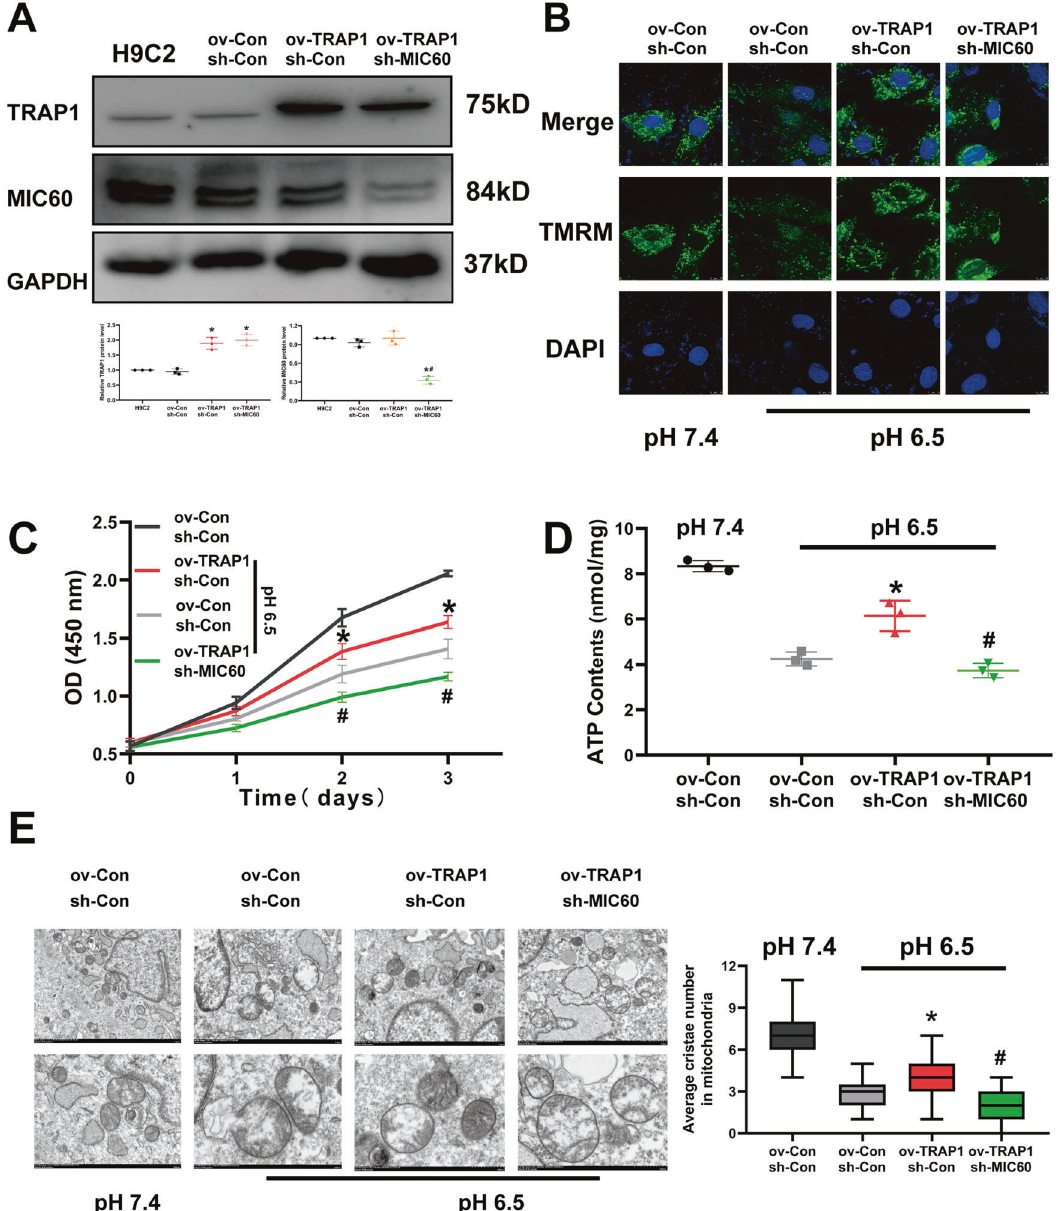
Fig. 4 TRAP1 protected mitochondrial cristae and function by increasing MIC60 protein levels in extracellular acidosis. A Western blot was used to determine the transfection ef fi ciency of TRAP1 and MIC60 in H9C2 cells. B Methyl tetramethylrhodamine staining was used to detect mitochondrial membrane potential of H9C2 cells. C CCK8 assay was used to detect the cell viability of H9C2 cells. D ATP assay was used to detect ATP levels of H9C2 cells. E Transmission electron microscopy was used to detect the ultrastructure of mitochondria of H9C2